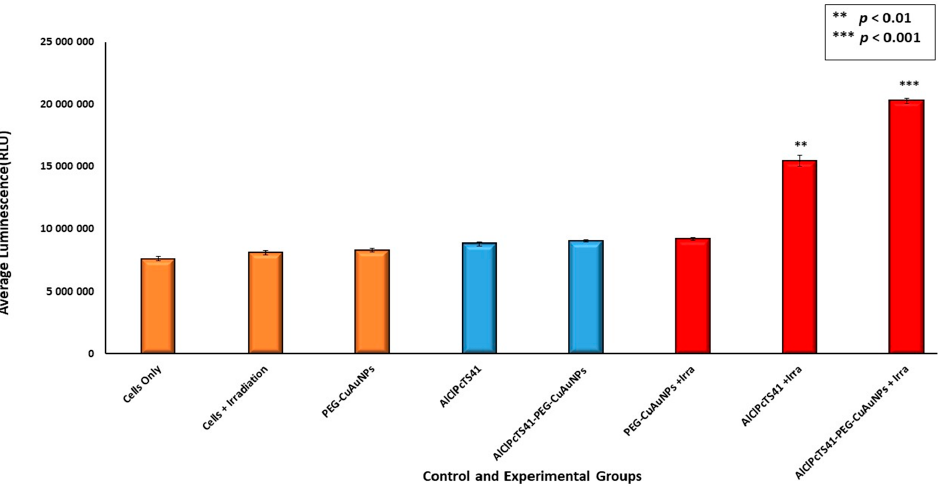
Figure 15. Intracellular ROS generation in Caco-2 cells treated with AlClPcTS41, PEG-CuAuNPs, and AlClPcTS41-PEG-CuAuNPs under 636 nm laser light irradiation. (** p < 0.01, *** p < 0.001 ) indicates statistical significance compared to cells